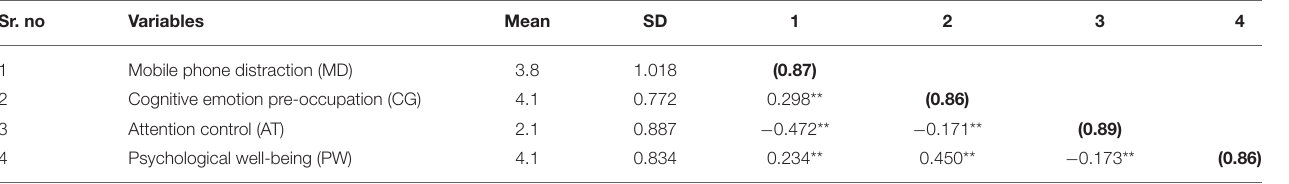
TABLE 3 | Correlations, mean, and standard